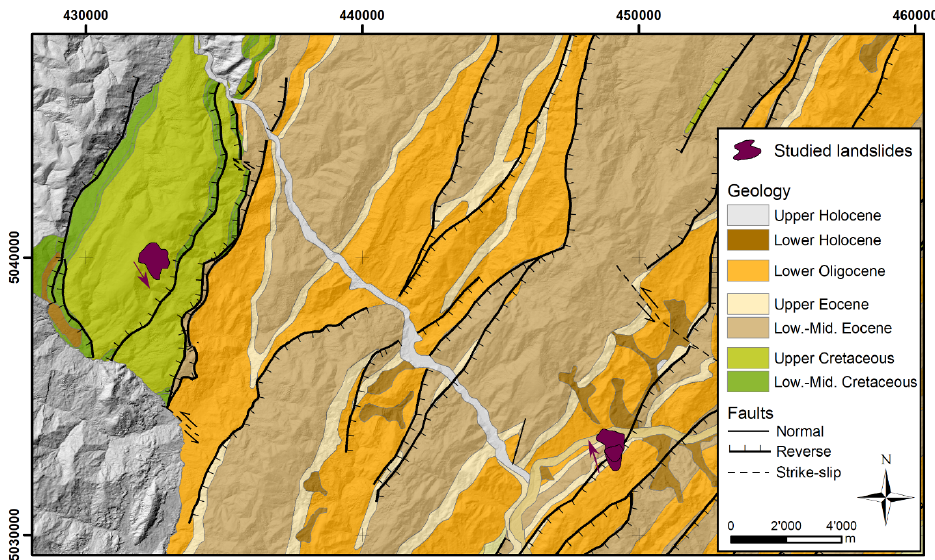
Figure 3. Geological map of the study area in the SE Carpathians (Buzau province; modified after [42]) with the Eagle’s Lake in the west and the Balta rockslide in the east of the map (coordinate system: UTM 35N). The arrows mark the sense of landslide